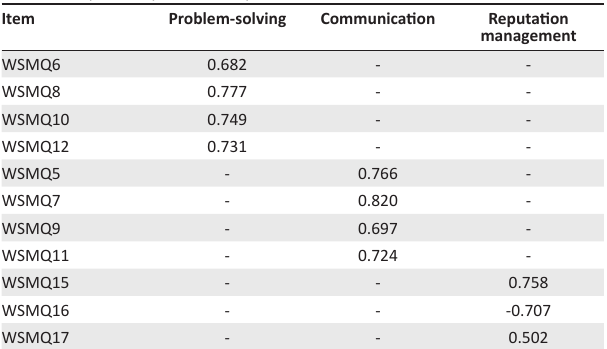
TABLE 4: Exploratory factor analysis